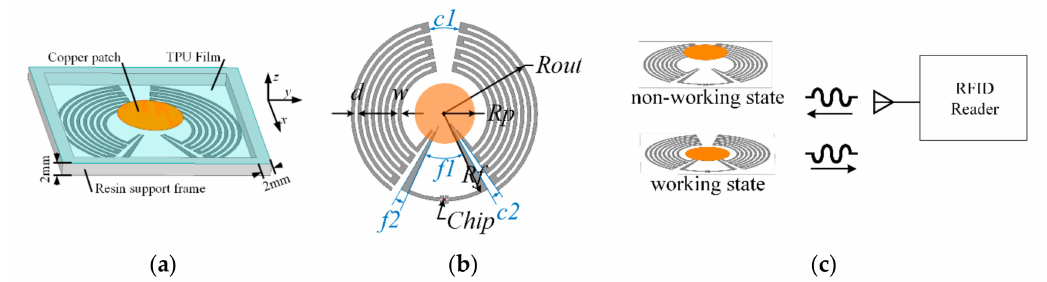
Figure 2. ( a ) Schematic with supporting frame and film; ( b ) geometry without supporting frame and film; ( c ) mechanism of the proposed radio frequency identification (RFID)